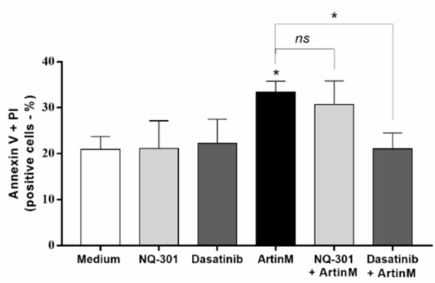
Figure 10. Dasatinib inhibits apoptosis of murine B cells induced by ArtinM. Murine B cells (5 × 10 5 cells/mL) seeded in 96-well microplates were pre-treated or not with 0.1 µ M NQ-301 or dasatinib for 210 min. The cells were stimulated or not with ArtinM (0.625 µ g/mL). The medium was used as a negative control. After 24 h, the cells were labeled with annexin V-FITC (5.0 µ g/mL) and PI (10.0 µ g/mL), and the frequency (%) of AnV+/PI+ B cells was determined by flow cytometry. Significant differences compared to the medium or stimulus with ArtinM are shown by *, p <